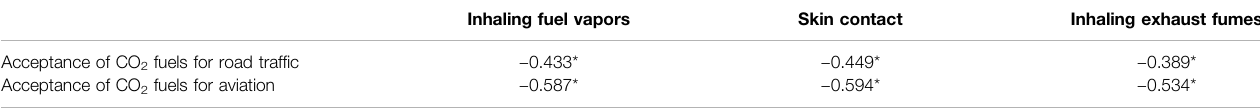
TABLE 4 | Bivariate correlations of acceptance of CO 2 -based fuels and evaluation of risks posed by different types of exposure to CO 2 -based fuels. Inhaling fuel vapors